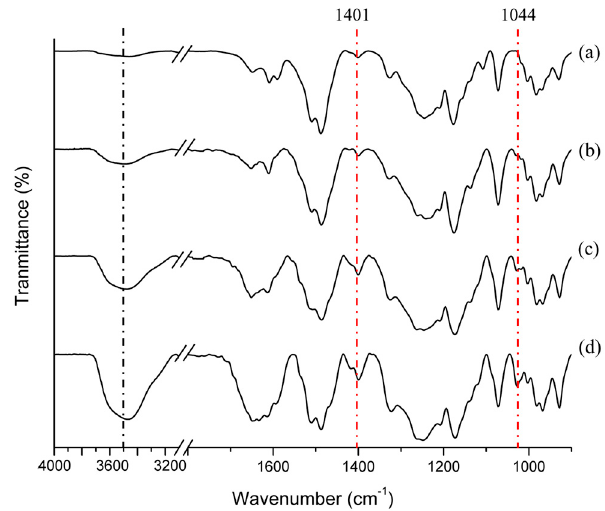
Figure 2. The IR spectra of block copolymers; ( a ) PABES-PAE, ( b ) SPABES-PAE (1:2), ( c ) SPABES-PAE (1:1), ( d ) SPABES-PAE (2:1). Table 1. The molecular weights ( M n , M w , and M z ), and polydispersity index (PDI) of block copolymers.